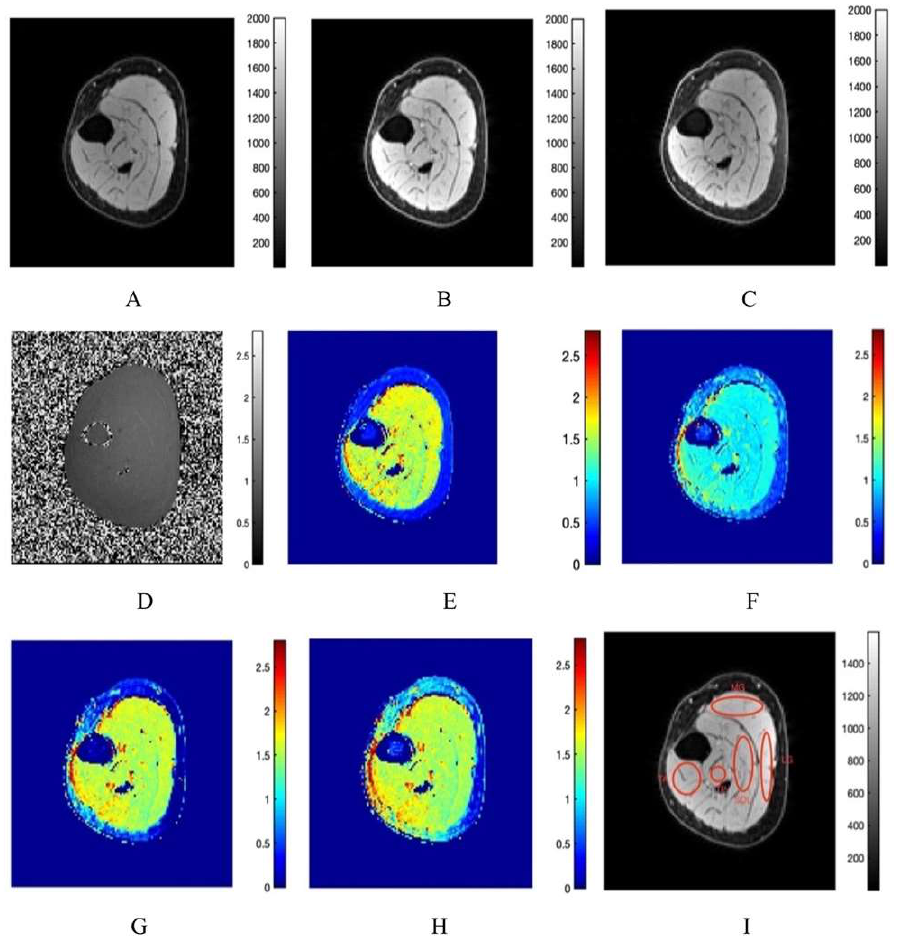
Figure 1. Typical acquired and computed images of the calf muscle (young subject shown here): 5 ◦ flip angle ( A ), 15 ◦ flip angle ( B ), 25 ◦ flip angle ( C ), B1+ map ( D ), T1 map with no fat suppression ( E ), T1 map with fat saturation ( F ), T1 map with water excitation (fast, 1:1 composite pulse) ( G ), T1 map with water excitation (normal, 1:2:1 composite pulse) ( H ). The ROIs in 5 muscle compartments used to extract T1 and MTsat values are shown in ( I ). The legend for the colormap for each computed image is shown next to it. The acquired images are in arbitrary units ( A – C ), for the B1+ map unitless (ratio of actual to nominal flip angle) ( D ), and for the T1 maps in seconds ( E – H ). It should be noted that images are presented rotated by 90 ◦ in order to accommodate all nine images with the color legends in one frame.